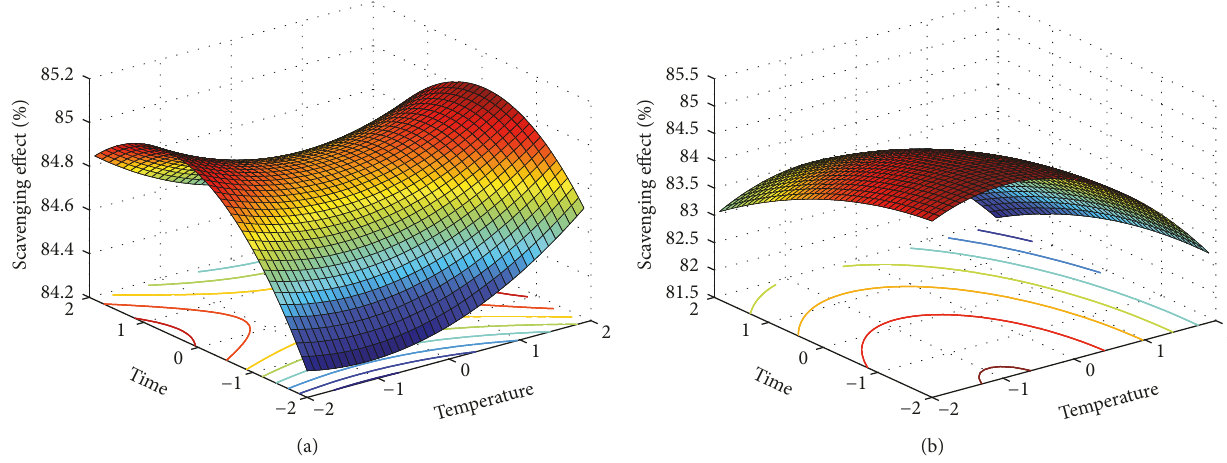
Figure 4: The surface plots of scavenging capacity of DPPH radical in aqueous extract (a) and ethanolic extract (b) as affected by roasting time and